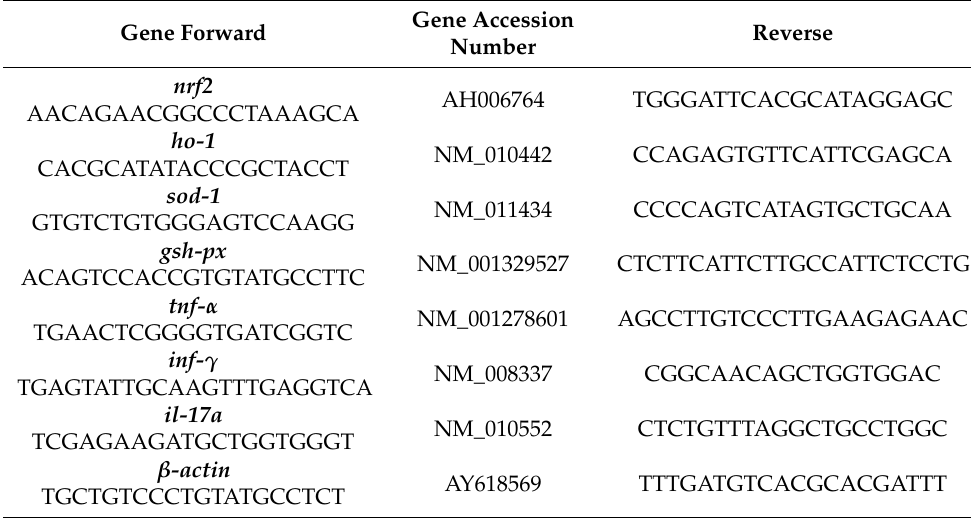
Table 1. Primers for